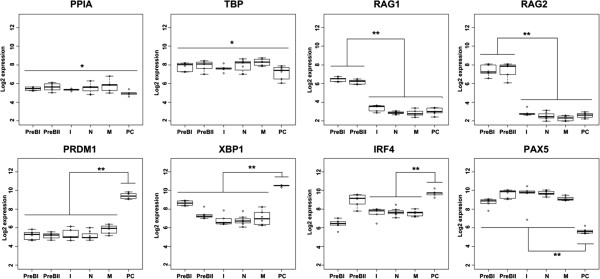
Biological validation. The expression values of selected genes in the B-cell subsets derived from the BM on the Exon array. Pre-B: Pre B cells, I: immature B cells, N: naïve B cells, M: memory B cells, PC: plasma cells. *p ≥ 0.05, **p < <0.001.